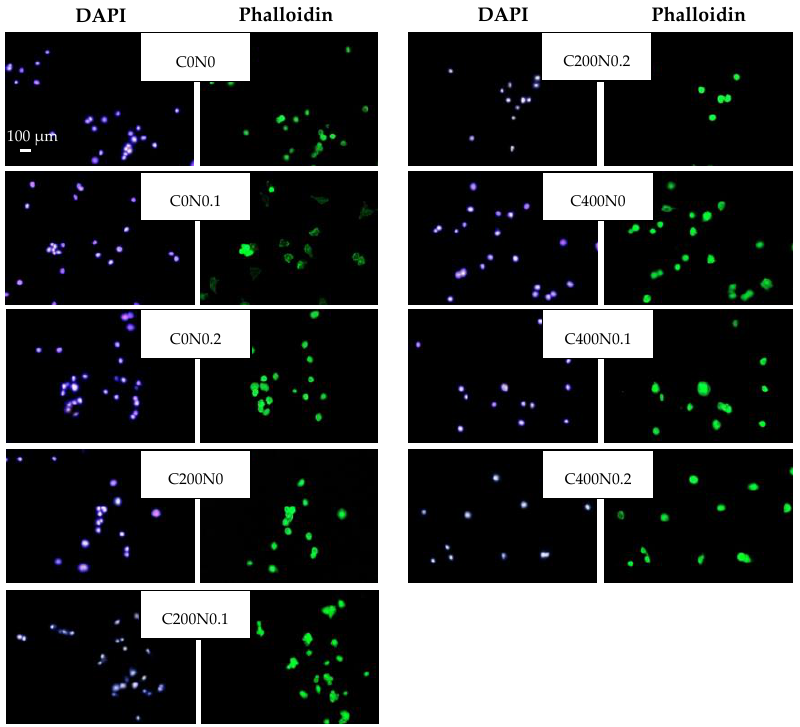
Figure 5. Growth curves showing proliferation rate of L929 cells cultured on hydrogel. Vertical bars represent standard deviation. Values followed by different superscript letters (a–f) are significantly different ( p < 0.05).